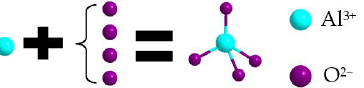
Figure 20. The schematic diagram of Rb 2 O polymerize the slag network.